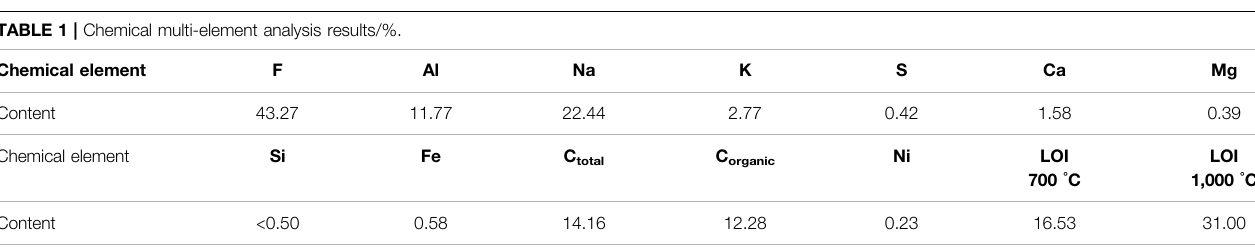
TABLE 1 | Chemical multi-element analysis